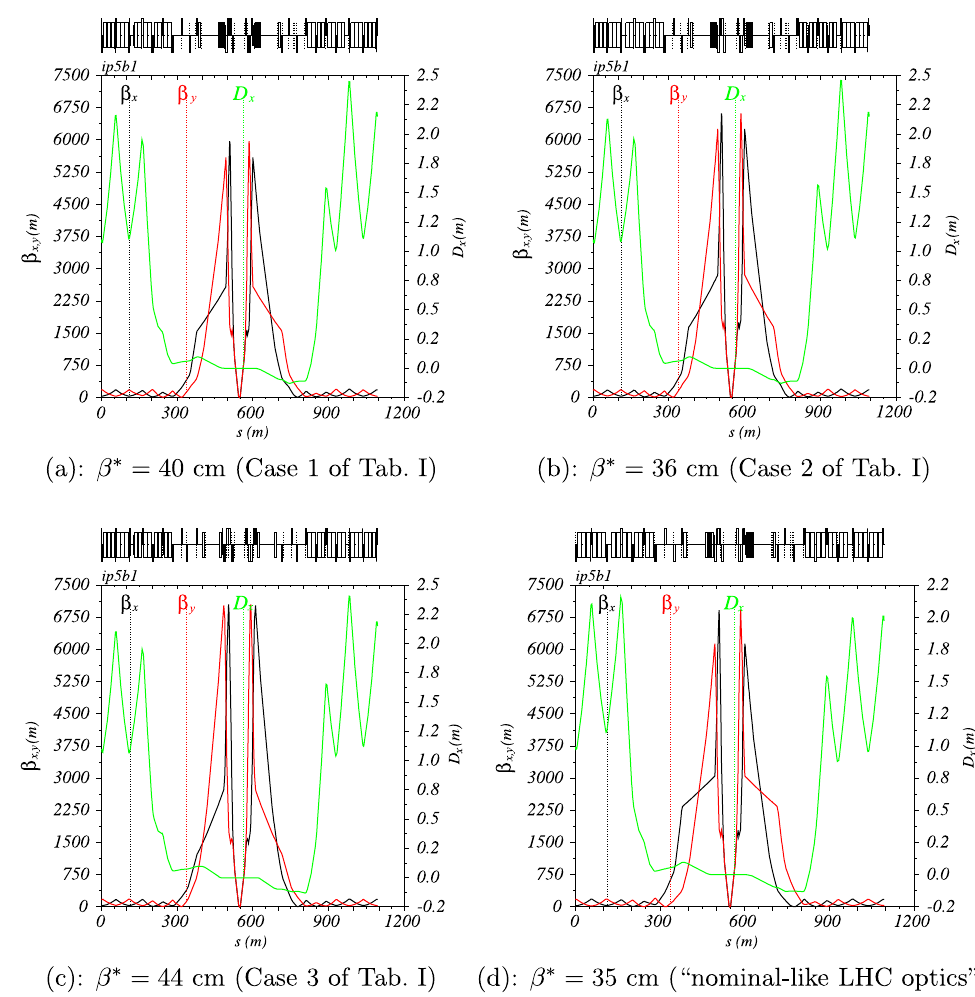
FIG. 5. Presqueezed ATS optics for Beam1 zoomed in the CMS experimental insertion for the three cases summarized in Table I [(a)–(c)], and compared with a nominal-like LHC collision optics (d), which has been already pushed beyond the gradient limits of some IR quadrupoles in order to reach (cid:1) (cid:1) ¼ 35 cm . The crossing scheme is assumed to be switched off in order to preserve the dispersion matching (see also Sec. III